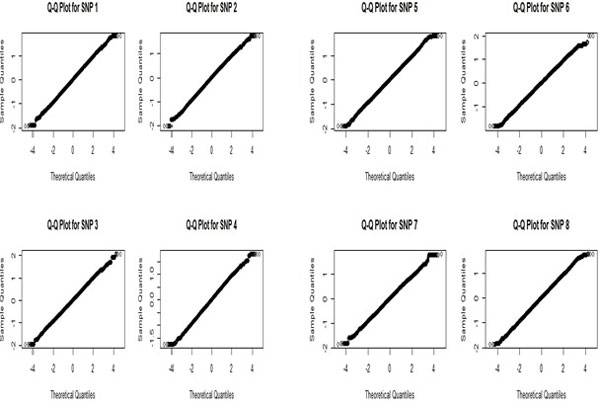
QQ-plot for eight SNPs.